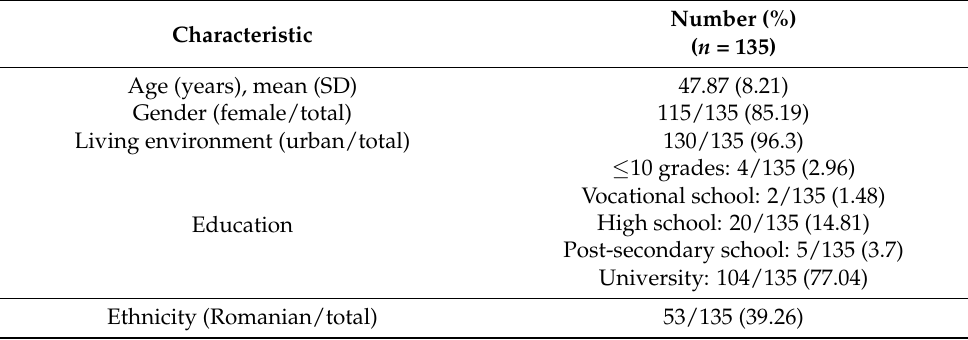
Table 1. Demographic characteristics of the studied population.